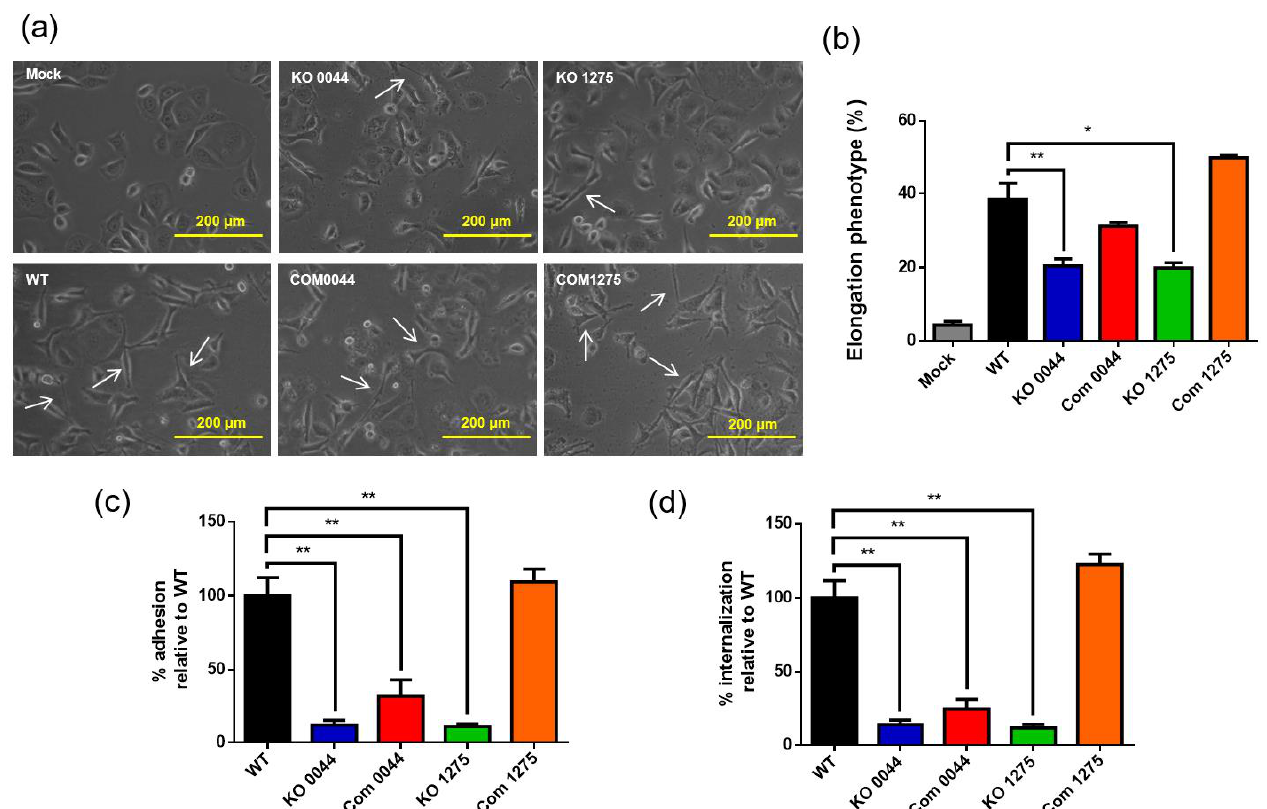
Figure 6. Effects of the HP0044- and HP1275 -disrupted mutations on bacterial virulence. ( a ) Morphological changes of the AGS cells infected by different H. pylori strains. The morphological changes of the AGS cells after H. pylori infection were documented by phase-contrast microscopy with 20 × magnification. The AGS cells exhibited long spindles and an elongated phenotype, indicated by arrows. ( b ) Quantitation of the AGS cells with the elongated phenotype after H. pylori infection. The percentage of elongated cells was quantified from 10 different 0.25 mm 2 fields. The data presented were derived from triplicate trials with statistical analysis (unpaired, two-tailed Student’s t -test; * p < 0.05 and ** p < 0.01). ( c ) Adhesion of the AGS cells by different strains of H. pylori infection. Various H. pylori strains were co-incubated with the AGS cells at an MOI (multiplicity of infection) of 100. The adhesion of different mutants measured by the viable plate counting method was compared to that of wild-type strain 26695 to obtain the relative percentage of bacterial adhesion. The data presented were derived from triplicate trials with statistical analysis (unpaired, two-tailed Student’s t -test; * p < 0.05 and ** p < 0.01). ( d ) Internalization of the AGS cells by different strains of H. pylori infection. Various H. pylori strains were co-incubated with the AGS cells at an MOI of 100. The internalization of various knockout mutants measured by the viable plate counting method was statistically compared to that of wild-type strain 26695 to obtain the relative percentage of bacterial internalization. The data pre- sented were derived from triplicate trials with statistical analysis (unpaired, two-tailed Student’s t -test; ** p < 0.01). WT, wild-type strain; KO, knockout mutant; and Com, knockout complementary